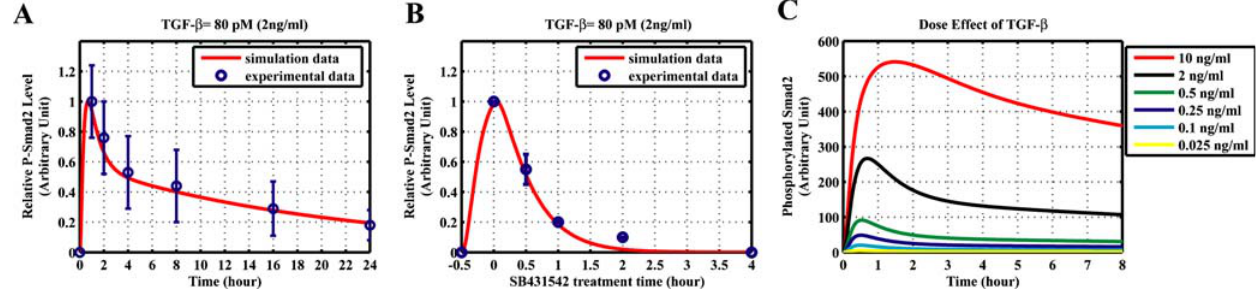
Figure 4. Comparison of experimental analysis and simulation results from the model obtained by only fitting the time course data. (A–B) The model has been over-fitted for ‘‘in-sample fit’’. (C) The model has a bad prediction for ‘‘out-sample fit’’. (A) Comparison of the model time course and experimental time course of Smad2 phosphorylation with 24 hours TGF- b treatment. Experimental data is the same as described in Figure 2A. (B) Effect of type I receptor kinase inhibitor SB431542. Experimental data is the same as described in Figure 2B. (C) Effects on Smad2 phosphorylation by different doses of TGF- b .